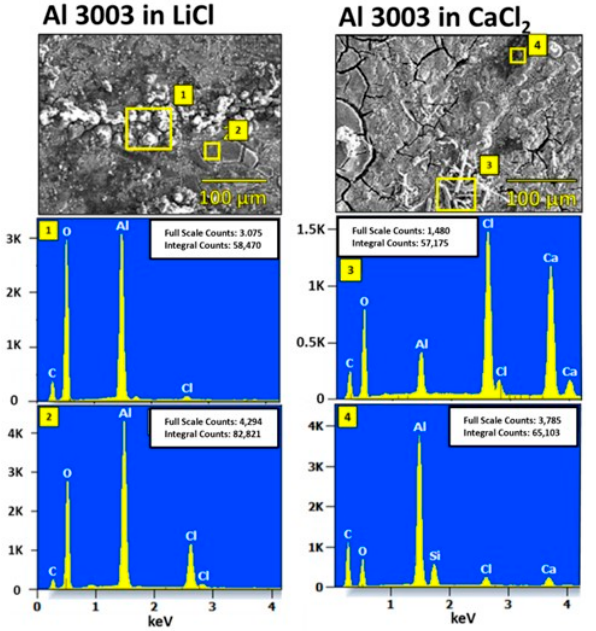
surface. For Al1100 in CaCl 2 , the surface composition appeared to be more homogenous, though significantly cracked and without metallic luster.